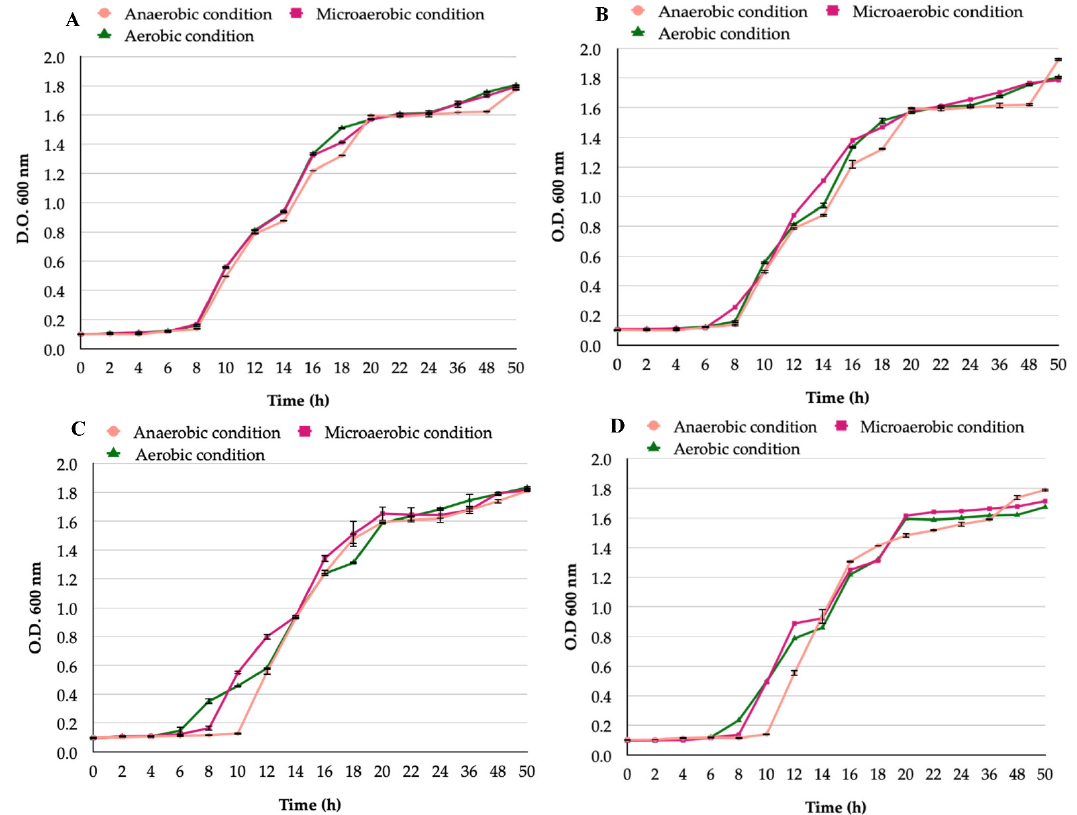
Figure 2. Growth curves of Candida strains under aerobic, microaerobic, or anaerobic conditions: ( A ) C. albicans ATCC 90028 reference strain; ( B ) C. glabrata ATCC 90030 reference strain; ( C ) C. albicans VT ‐ 3 clinical strain; ( D ) C. glabrata LEO ‐ 37 clinical strain. No significant differences were present among these growth curves ( p = 0.5).